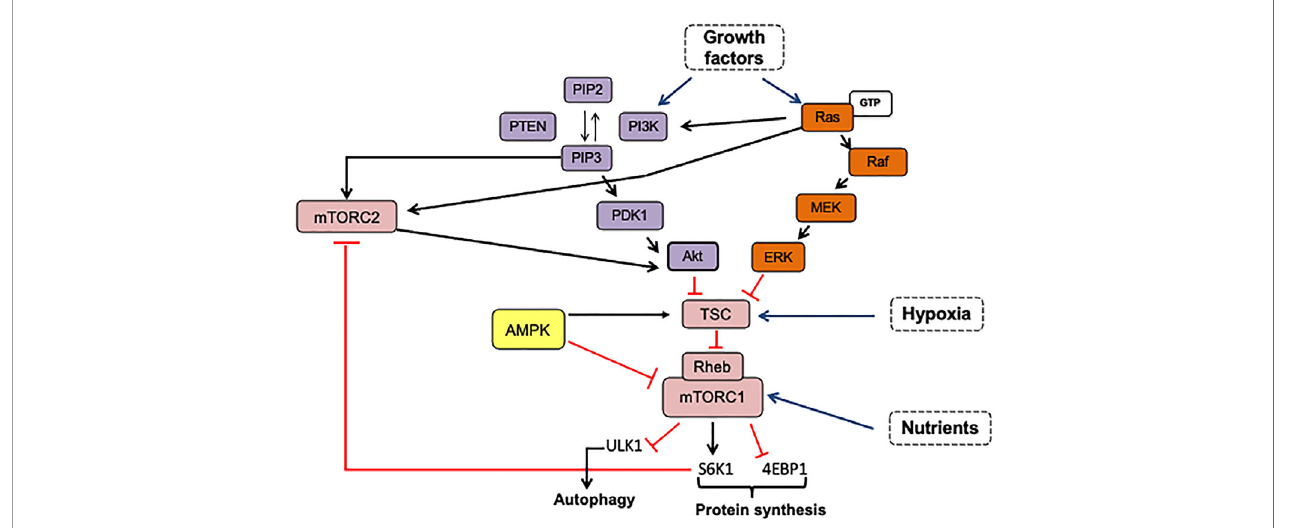
FIGURE 2 | mTOR is activated by growth factors via PI3K-Akt and RAS/MAPK pathways. The phosphorylation of phosphatidylinositol 4,5 biphosphate (PIP2) is catalyzed by PI3K producing PIP3. Once PIP3 is formed, it induces the recruitment of proteins with PH domain such as PDK1, Akt, and mTORC2 complex, facilitating Akt-Thr308 and Akt-Ser473 phosphorylation by PDK1 and mTORC2, respectively. Activated Akt inhibits the TSC complex and promotes mTORC1 activation by Rheb-binding. The Ras/AMPK pathway can regulate both mTOR complexes via the Ras-Raf-MEK-ERK signaling cascade. Activated ERK inhibits the TSC complex by direct phosphorylation, and Ras-GTP can bind to mTORC2, increasing its kinase activity. mTORC1 activation in response to amino acids can be dependent or independent on Rag GTPases. Also, mTORC1 can control its own activation and mTORC2 activity. mTORC2 is negatively regulated by mTORC1- S6K1 that phosphorylates mSN1 and Rictor. The arrows indicate: ! , activation signals; ┴ , inhibition signals; ! pathway activators.